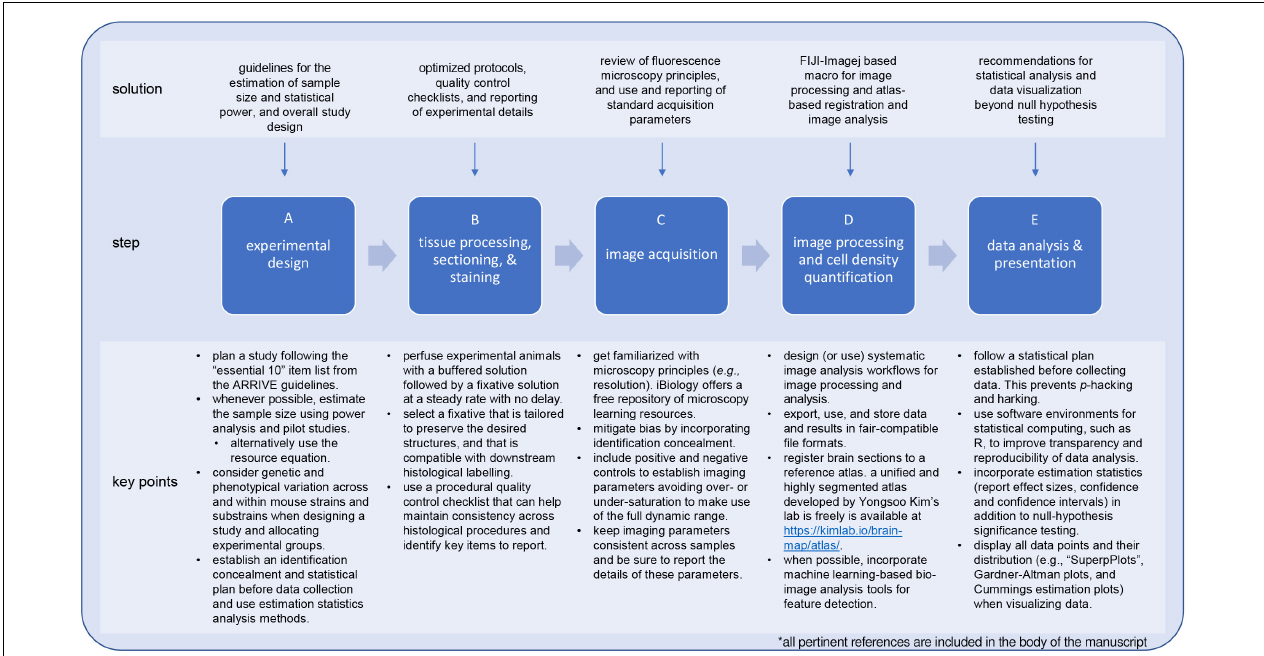
FIGURE 4 | Solutions and recommendations for the implementation of systematic and open science framework to studies for quantifying cell-types in the mouse brain. Familiarization with experimental design concepts and principles helps to identify sources of bias early on and establish plans to mitigate these, resulting in conducting research in an efficient and reliable way. For example, using the ARRIVE guidelines to design an experimental plan not only provides a procedural a structure but also a reference to identify critical items to report on a study (A). Likewise, be acquainted with research methods and equipment is paramount to keep consistency across processed samples (B,C). Using quality control checklist for these steps can facilitate achieving this goal while at the same time provide a reference when it comes to reporting the study. When it comes to process images and extracting data, using workflows based on user-friendly and open-source tools (e.g., FIJI-ImageJ) will contribute to the reproducibility and usability of a study (D). Lastly, incorporating estimation statistics analysis to statistical analysis plan improves the interpretation of study outcomes by providing a quantitative measure of the extent of an outcome (i.e., effect size) and clearly depicting variability. The latter is further benefited by plotting all the data points and their respective distributions using highly descriptive types of scatterplots such as “ SuperPlots ” or Gardner-Altman and Cummings estimation plots (E). Implementing these items not only contributes to open science, but also enhanced the robustness of a research